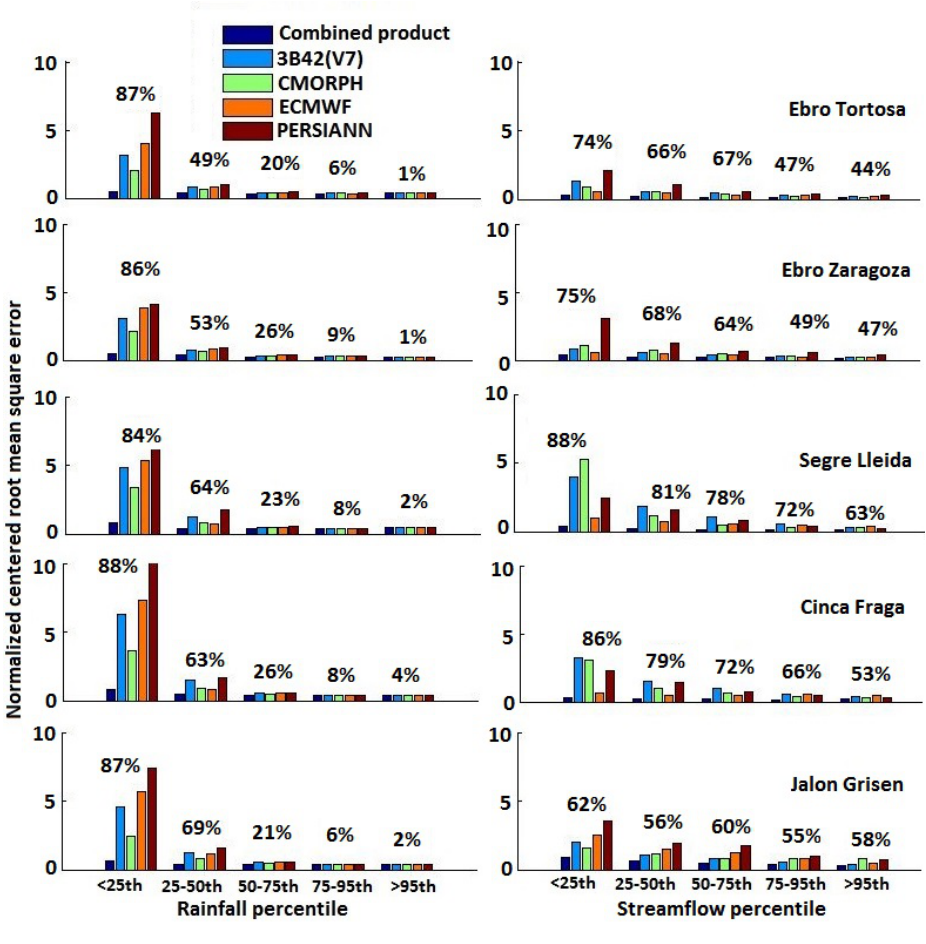
Figure 12. Normalized centered root mean square error for basin-average rainfall and streamflow. The relative error reductions for the combined product (relative to other products) are shown above the